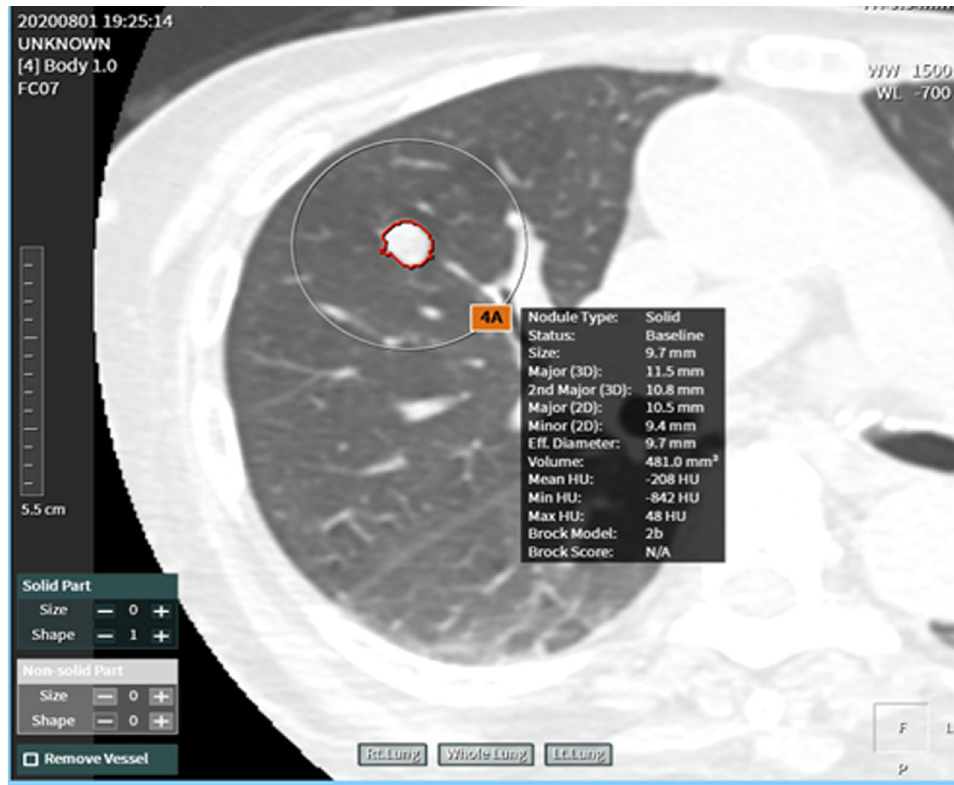
Fig. 2 Axial CT scan showing solid pulmonary nodule, automatically detected, measured, and classified (Lung‑RADS